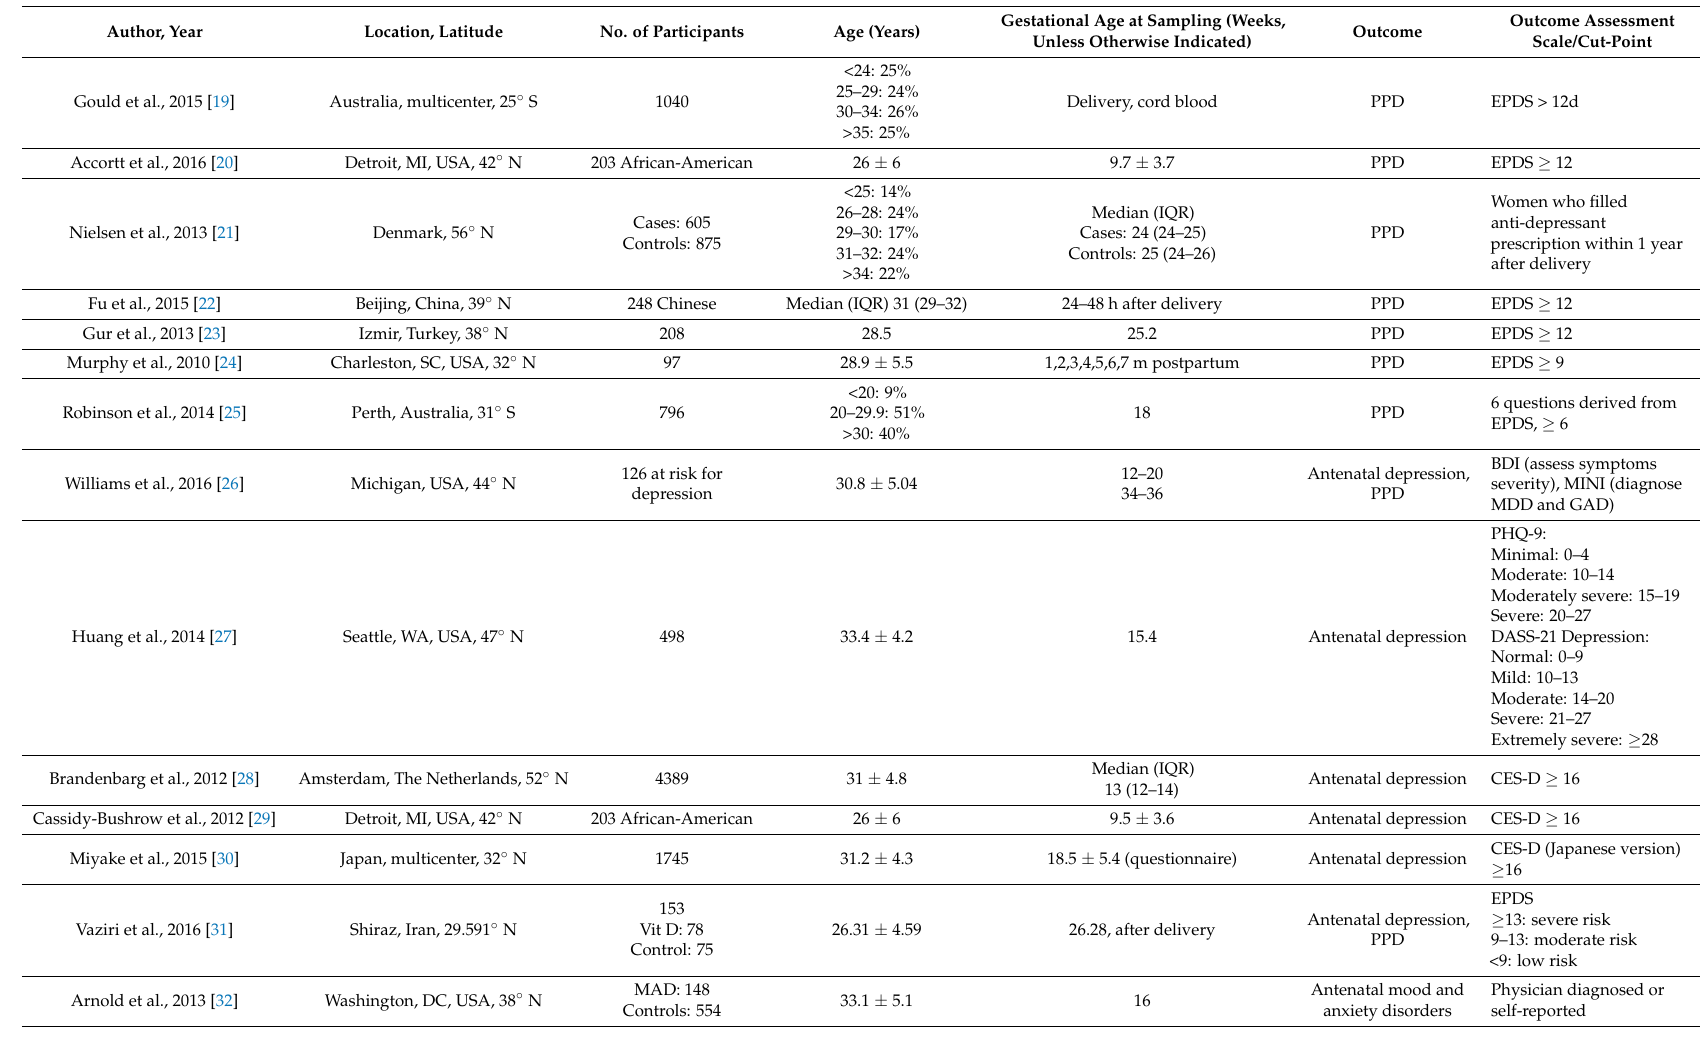
Table 1. Characteristics of included